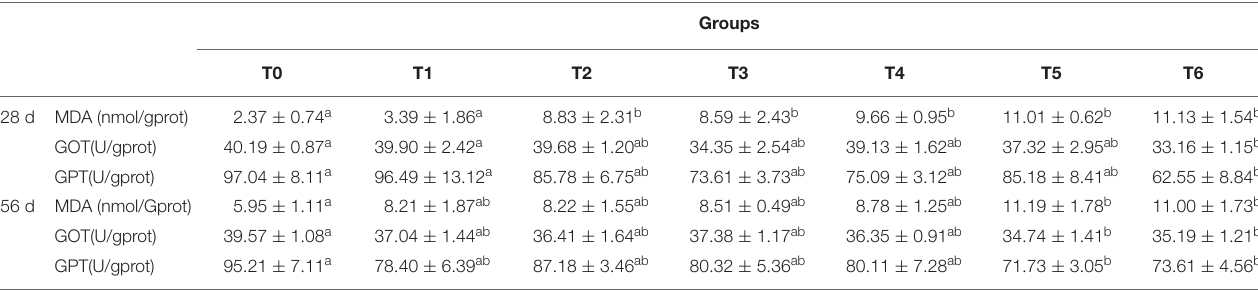
TABLE 4 | Effects of histamine on liver biochemical indices of grouper ( Epinephelus coioides ).